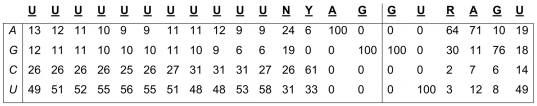
Ratcheting point consensus sequence (RP-site).The RP-site consensus was obtained from our purged sample of 11,315 non-redundant human gene sequences (with <50% sequence identities between each other) from the human Exon-Intron Database, release 35p1. The top row contains the consensus sequence derived from the frequency information below. Each nucleotide in the consensus sequence is a column in the matrix whose rows show the frequencies found for each given nucleotide at that position. The first column gives the nucleotides corresponding to the frequency information.